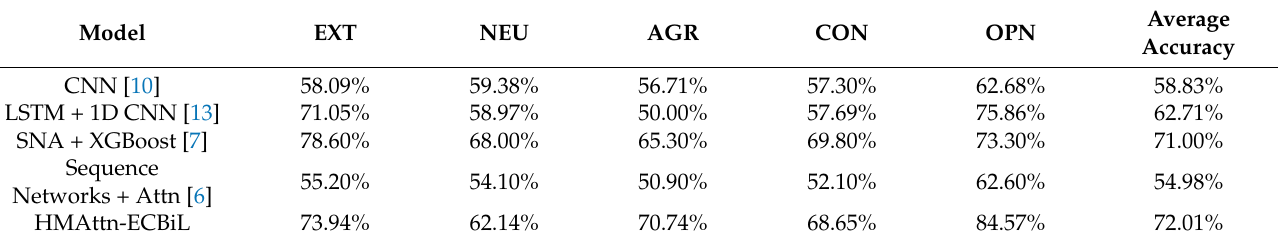
Table 5. Comparison of classification accuracy between hybrid and single models on MyPersonality